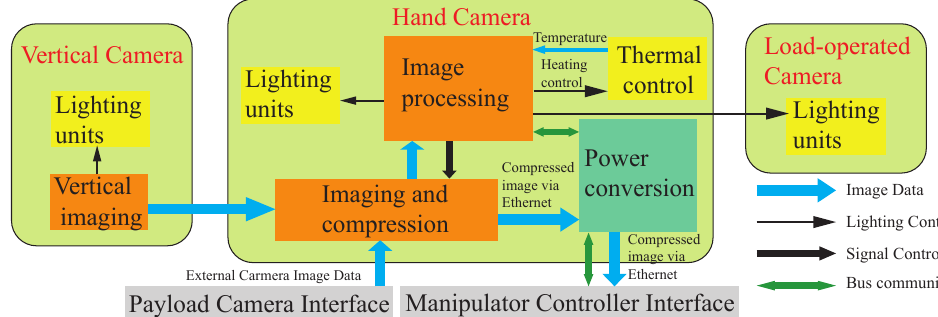
Figure 3. Composition block diagram of the